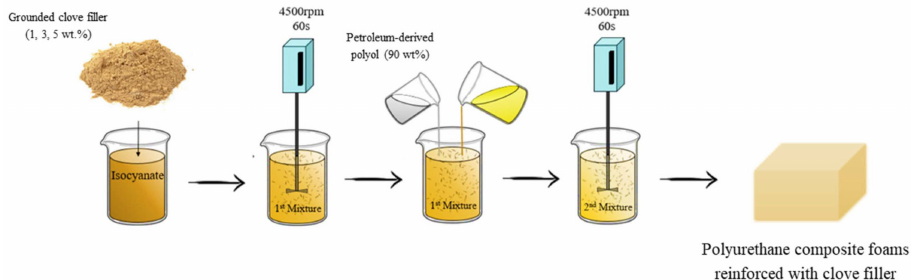
Figure 1. Schematic procedure of the synthesis of polyurethane (PU) composite